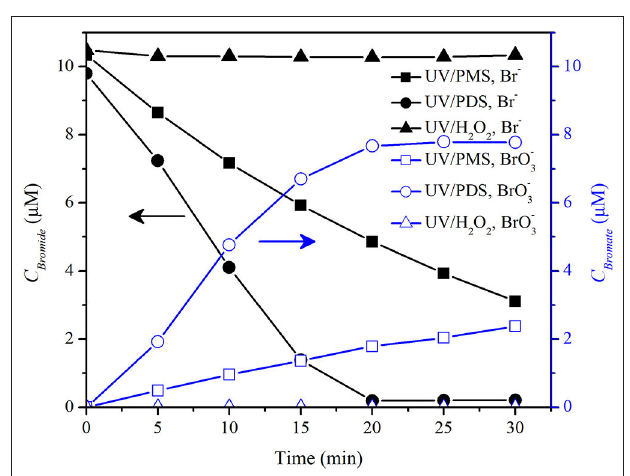
FIGURE 7 | Concentrations of bromide and bromate in UV/PMS, UV/PDS, and UV/H 2 O 2 . Conditions: [PMS] = 200 µ M as 1/2 Oxone, [PDS] = 200 µ